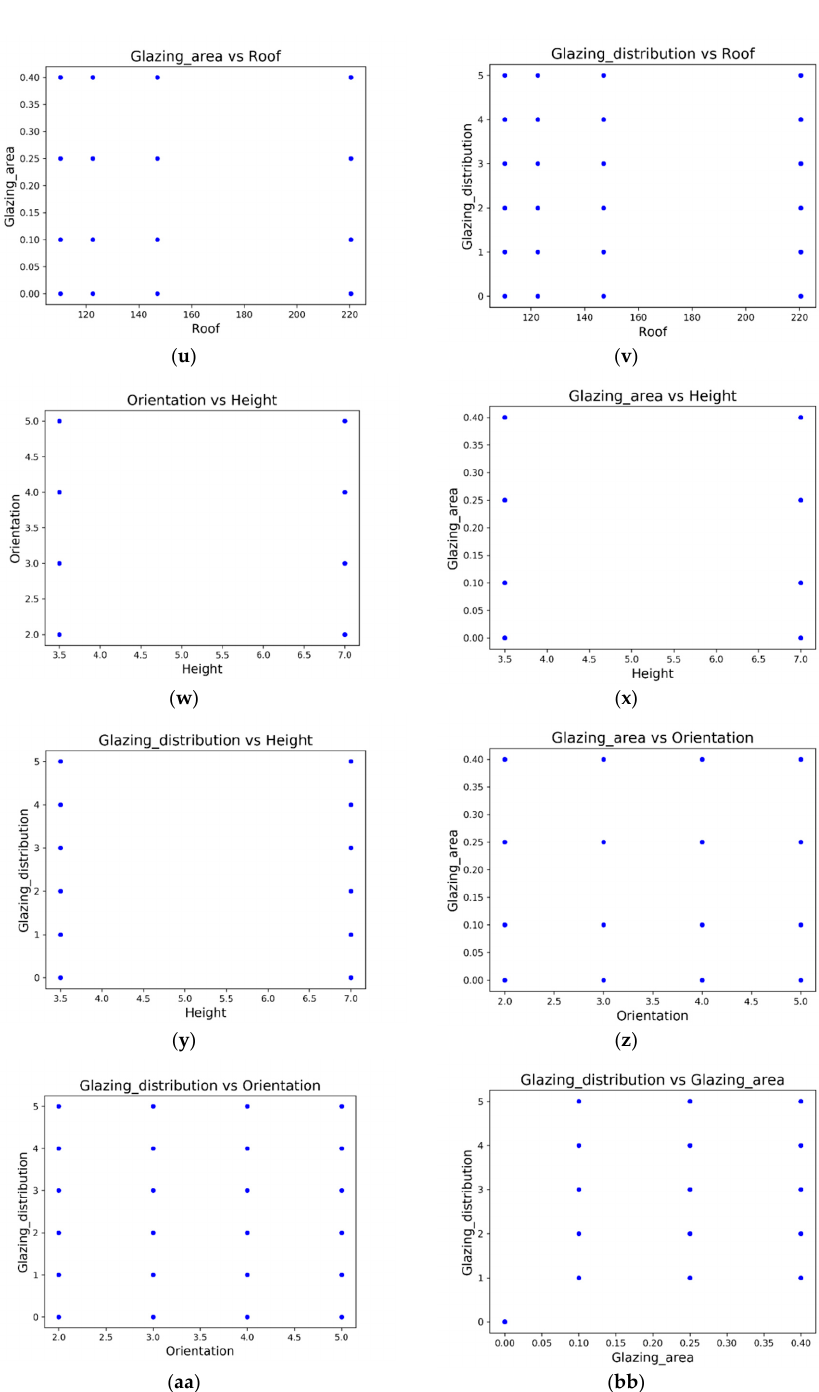
Figure 1. Relationship between the independent variables for the cooling load problem. ( a ) Surface vs. Compactness; ( b ) Wall vs. Compactness; ( c ) Roof vs. Compactness; ( d ) Height vs. Compactness; ( e ) Orientation vs. Compactness; ( f ) Glazing area vs. Compactness; ( g ) Glazing distribution vs. Compactness; ( h ) Wall vs. Surface; ( i ) Roof vs. Surface; ( j ) Height vs. Surface; ( k ) Orientation vs. Surface; ( l ) Glazing area vs. Surface; ( m ) Glazing distribution vs. Surface; ( n ) Roof vs. Wall; ( o ) Height vs. Wall; ( p ) Orientation vs. Wall; ( q ) Glazing area vs. wall; ( r ) Glazing distribution vs. Wall; ( s ) Height vs. Roof; ( t ) Orientation vs. Roof; ( u ) Glazing area vs. Roof; ( v ) Glazing distribution vs. Roof; ( w ) Orientation vs. Height; ( x ) Glazing area vs. Height; ( y ) Glazing distribution vs. Height; ( z ) Glazing area vs. Orientation; ( aa ) Glazing distribution vs. Orientation and ( bb ) Glazing distribution vs. Glazing